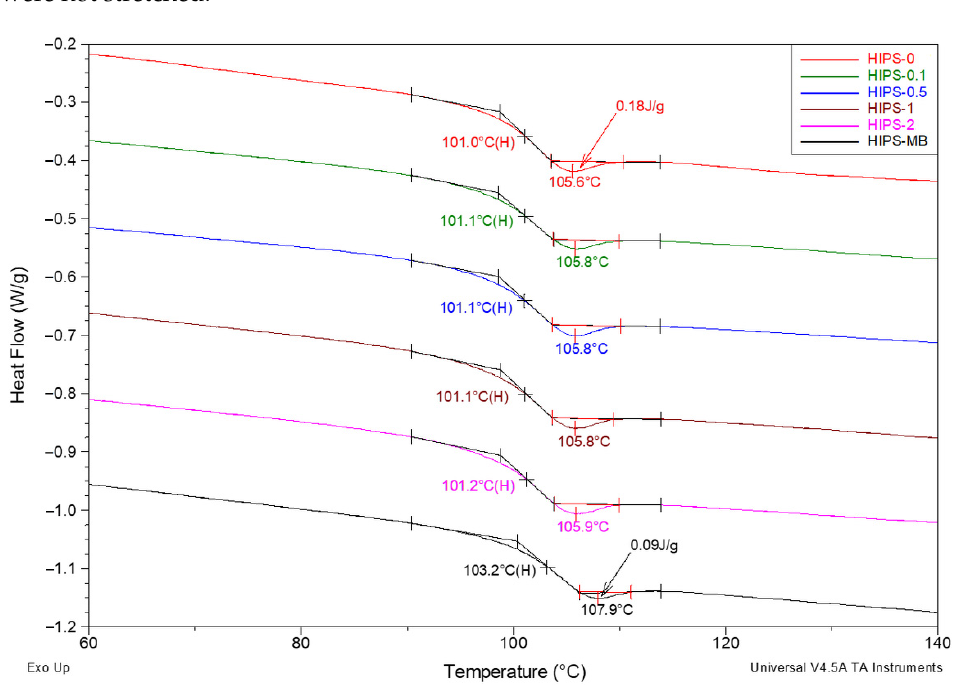
Figure 8. Summary of DSC curves for a series of HIPS samples, created after melting the filaments, registered during the second heating cycle in the range between 40 and 140 °C. Measurements carried out under a nitrogen atmosphere, measurement conditions as above. Analysis of the thermal glass transition area.